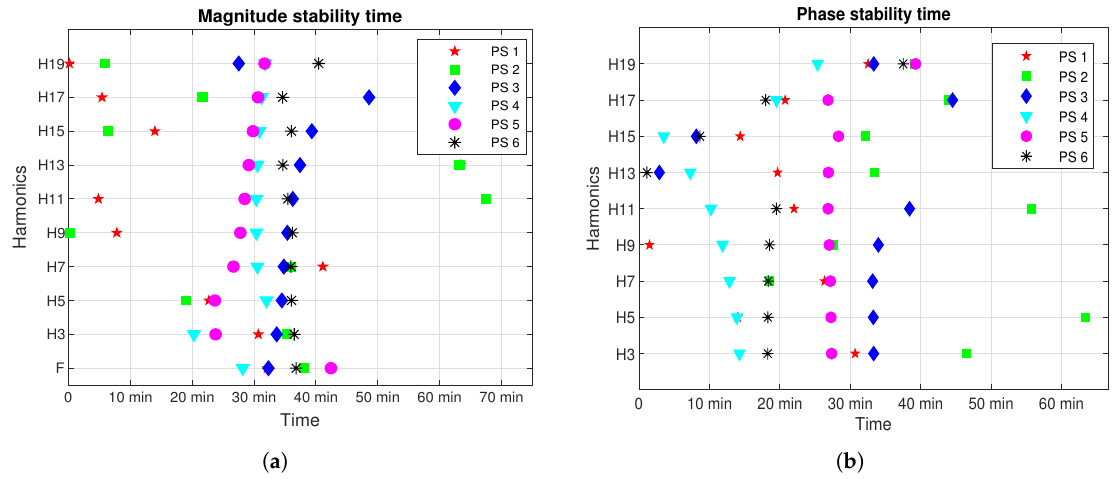
Figure 7. Stability time of current harmonics for all SMPSs ( a ) Magnitude ( b )